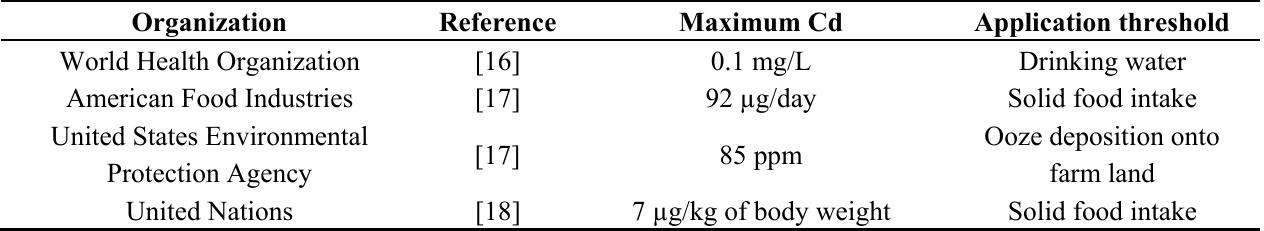
Table 6. Maximum allowable concentrations of cadmium